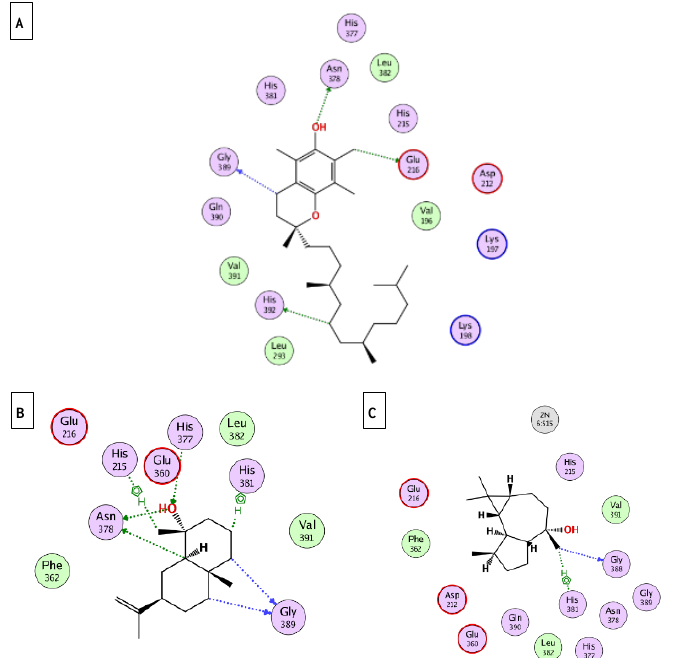
Figure 6. 2D binding modes of α -tocopherol ( A ); selin-11-en-4- α -ol ( B ); viridiflorol ( C ) to the active binding sites of tyrosinase.